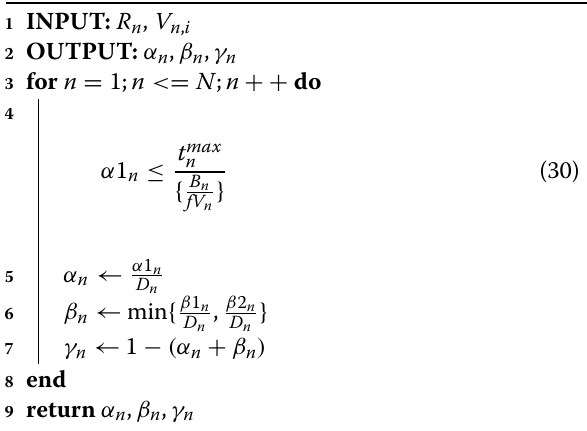
Algorithm 2: To estimate the offloading ratios